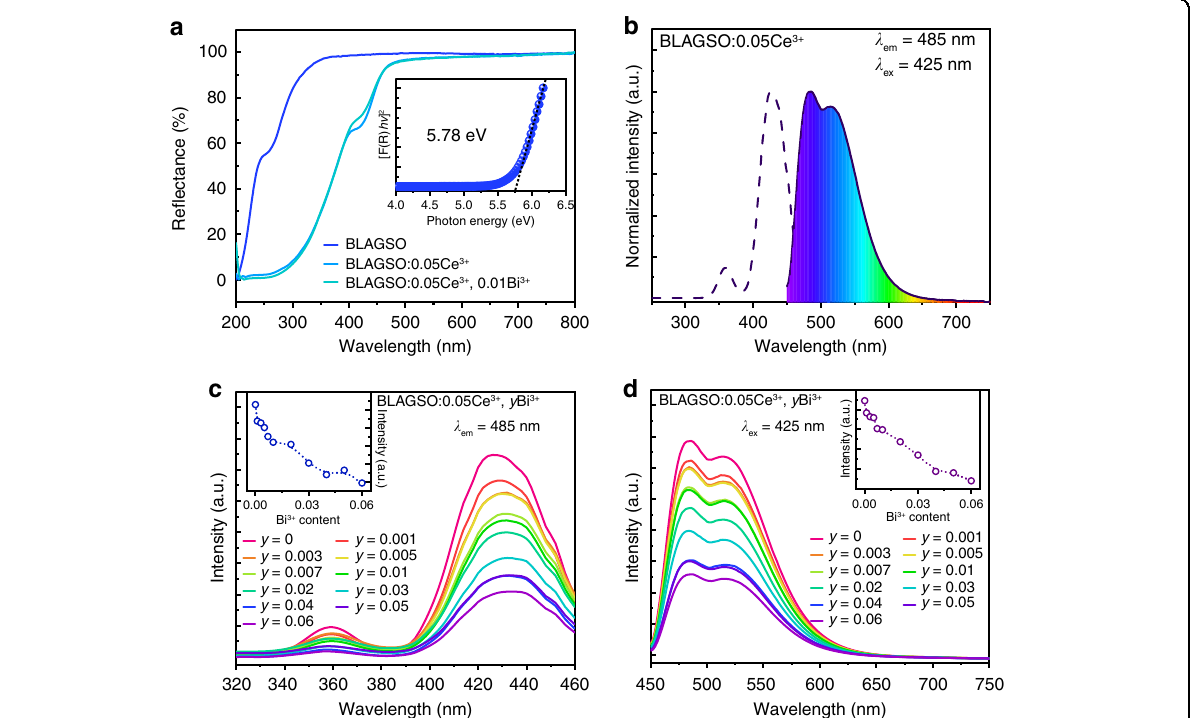
Fig. 3 Photoluminescence properties. a DR spectra of BLAGSO, BLAGSO:0.05Ce 3 + , and BLAGSO:0.05Ce 3 + , 0.01Bi 3 + . Inset: the experimental E g of BLAGSO. b PLE and PL spectra of BLAGSO:0.05Ce 3 + . c PLE spectra of BLAGSO:0.05Ce 3 + , y Bi 3 + . Inset: the PLE intensity of BLAGSO:0.05Ce 3 + , y Bi 3 + . d PL spectra of BLAGSO:0.05Ce 3 + , y Bi 3 + . Inset: the PL intensity of BLAGSO:0.05Ce 3 + , y Bi 3